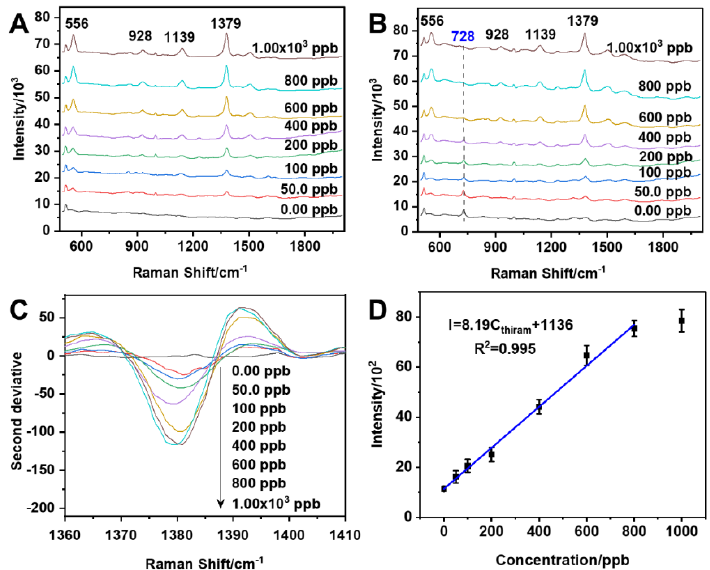
Figure 6. Averaged Raman spectra of 0.00~1.00 × 10 3 ppb thiram in ( A ) ethanol and ( B ) spiked in a diluted apple juice sample; ( C ) the second derivatives of the spectra A at 1379 cm − 1 and ( D ) linear curve plotted based on the spectra B at 1379 cm − 1 . The spectra in Figure A , B were averaged over 15 random measurements from triplicate experiments. The spectra at 0 ppb suggest that background signals do not a ff ect SERS measurement.